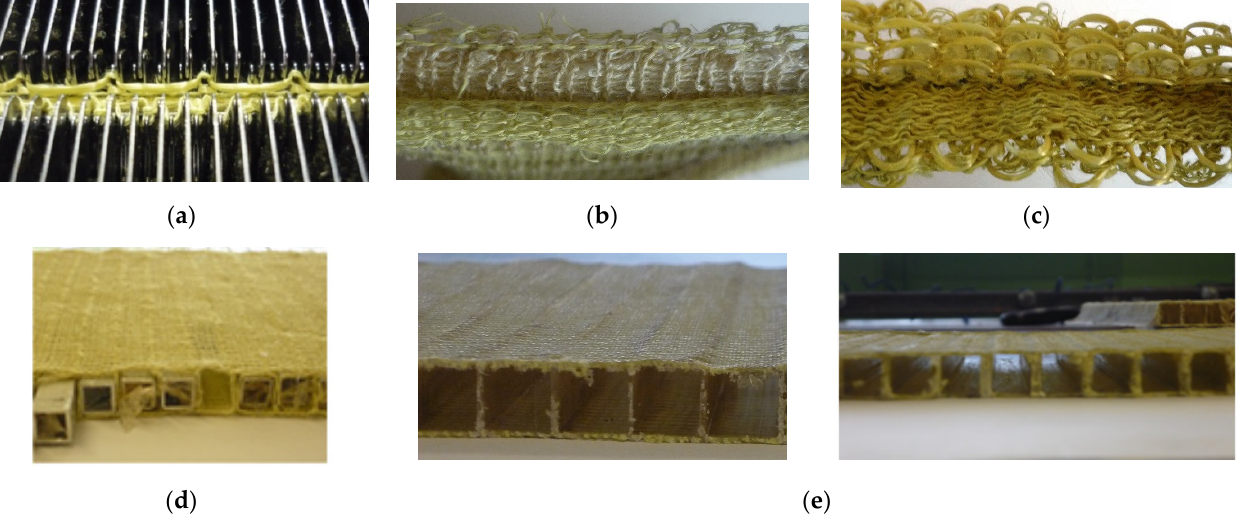
Figure 1. Composite reinforced with sandwich knitted fabrics—machine view ( a ), aspect of the outer layers with ( b ) and without in-lay yarns ( c ), preparation of the knitted reinforcement–insertion of moulds ( d ) and final aspect of the knitted spacer reinforced composite ( e ).